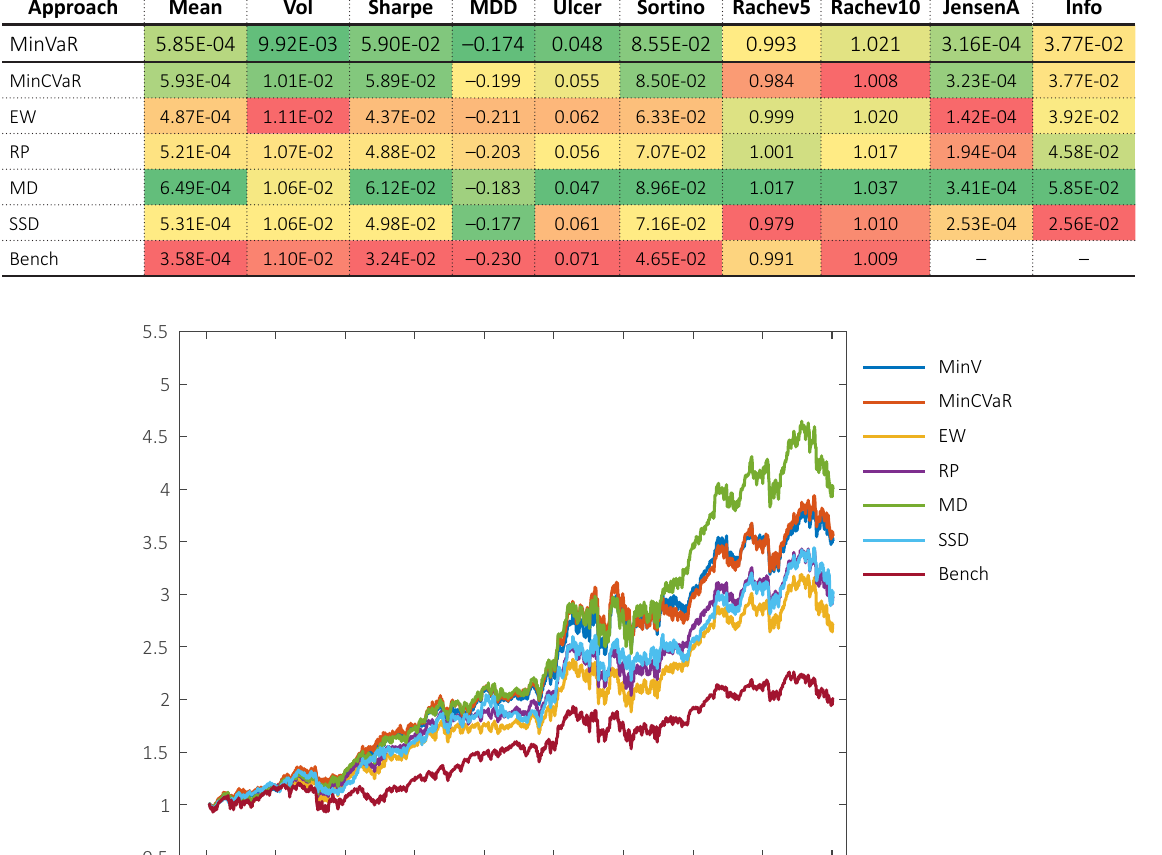
Figure 4. Out-of-sample compounded return for all models using minimum variance preselection Table 5. Out-of-sample results using Z-score preselection